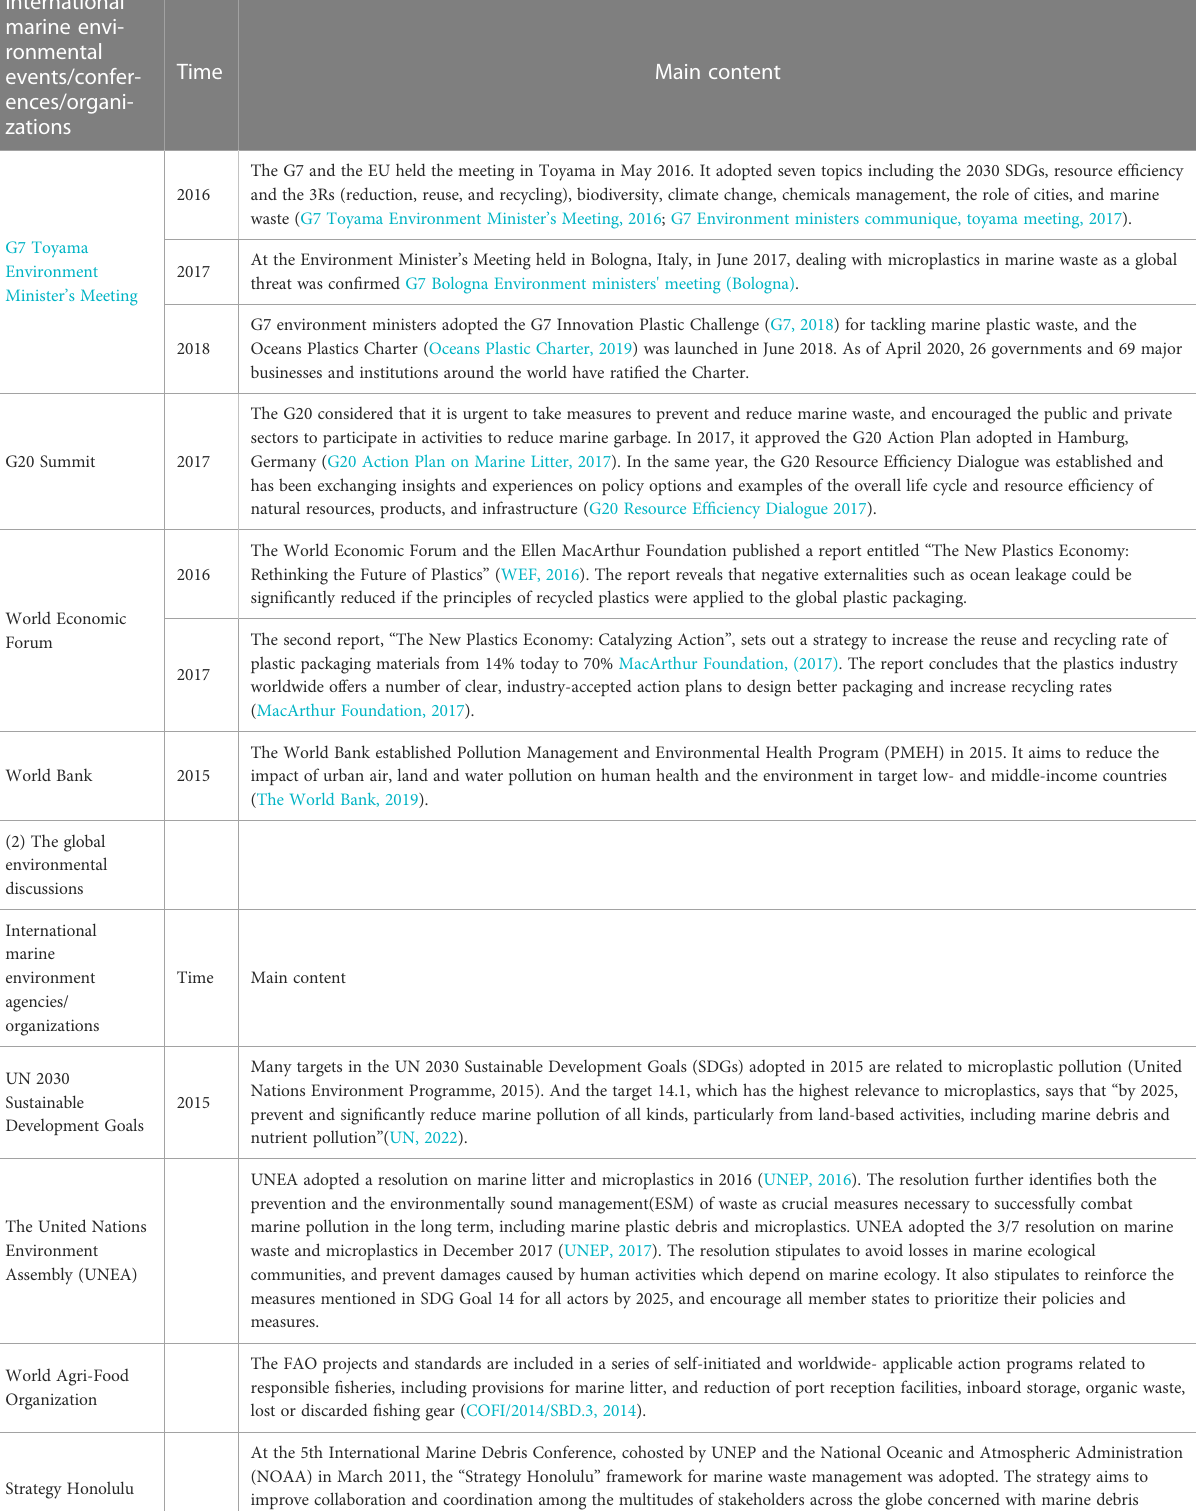
TABLE 4 The global political and economic